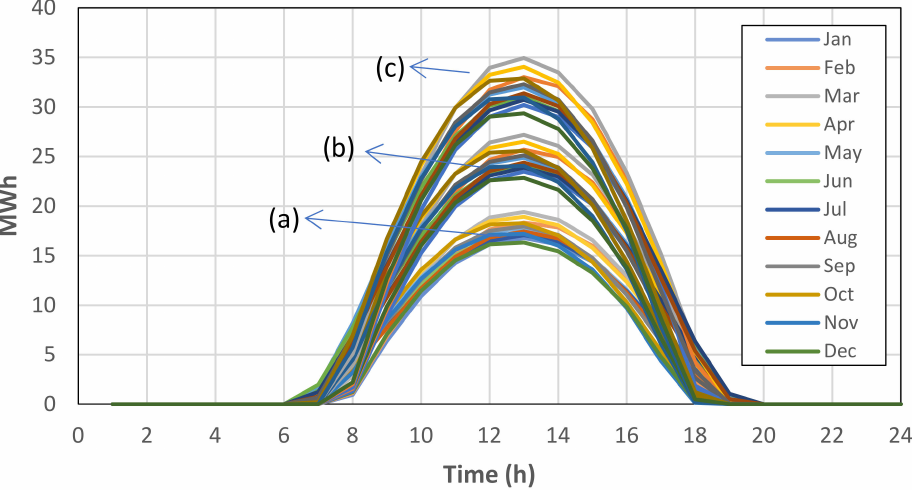
Figure 11. Average hourly profiles of total photovoltaic power output for; ( a ) 25 MW of PV capacity, ( b ) 35 MW of PV capacity, ( c ) 45 MW of PV capacity.